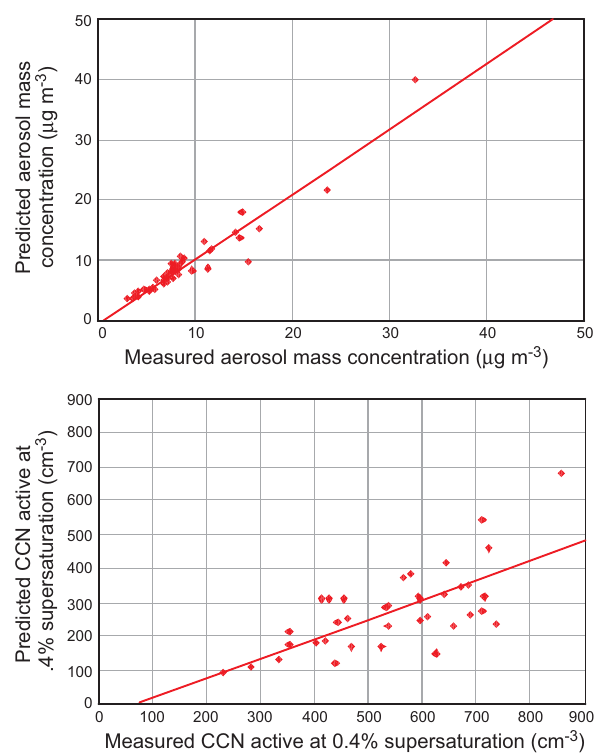
Figure 9 (a, top) : Regression of the total mass predicted by PMF onto the observed total masses; (b, bottom) regression of the PMF predicted CCN concentration active at 0.4% supersaturation onto those calculated from the size distribution and composition measurements.